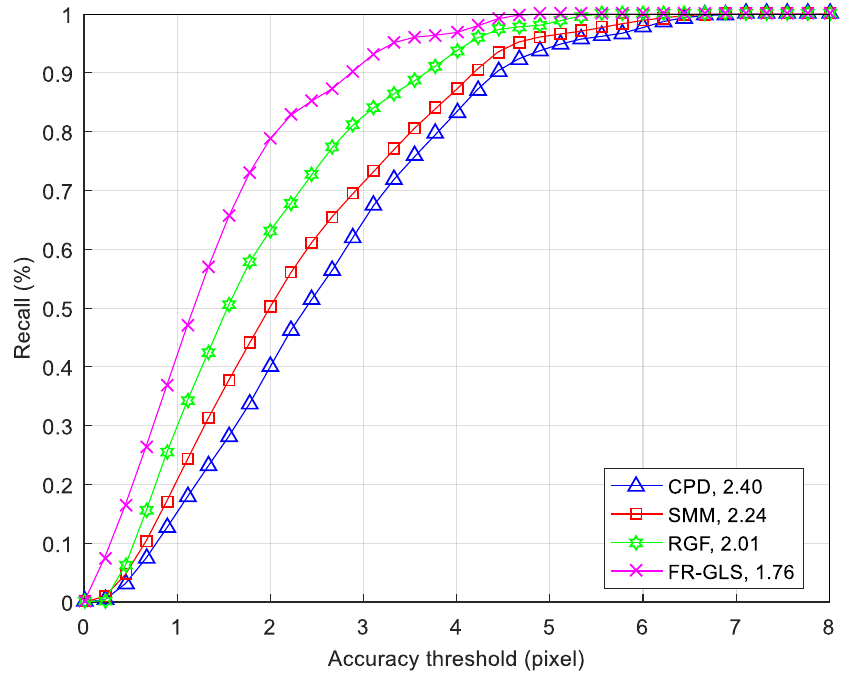
Figure 8. Quantitative comparisons of multi-spectral face image pairs with 6 individuals in Figure 7.